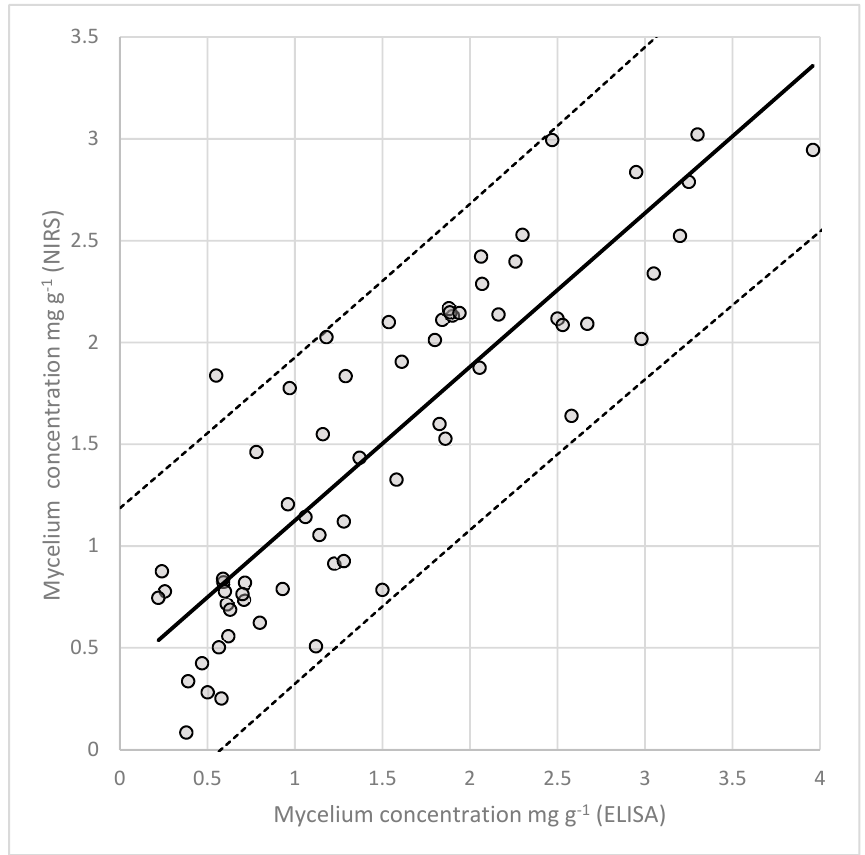
Figure 5. Internal validation comparing the concentrations of in planta fungal mycelium measured with an ELISA test and the ones predicted by NIR spectroscopy using the MPLS regression. The IC 95% is represented by the dashed lines.